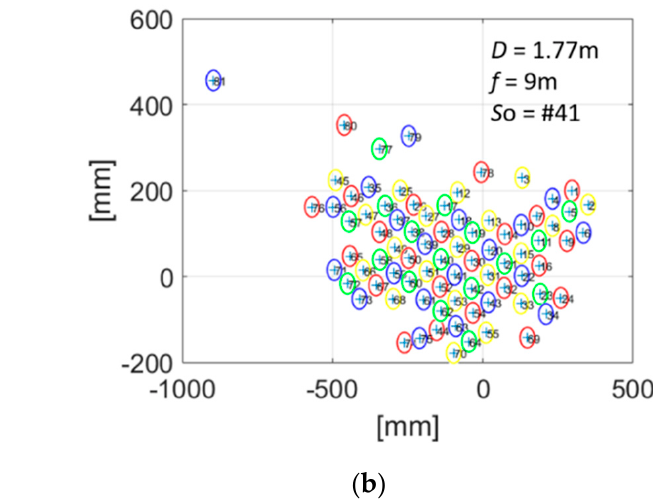
reuse scheme used is the four-color scheme; a reflector is proposed for each color: red, green, blue, and yellow, where each color represents a frequency and a polarization.